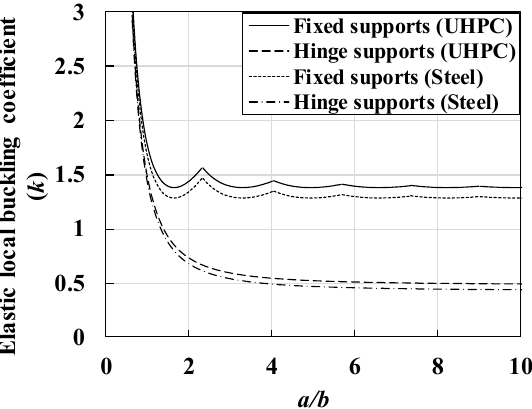
Figure 6. Comparison of elastic local buckling coefficient ( k ) for UHPC and steel. Table 2. Elastic flange buckling coefficient ( k ) according to the Poisson’s ratio ( µ